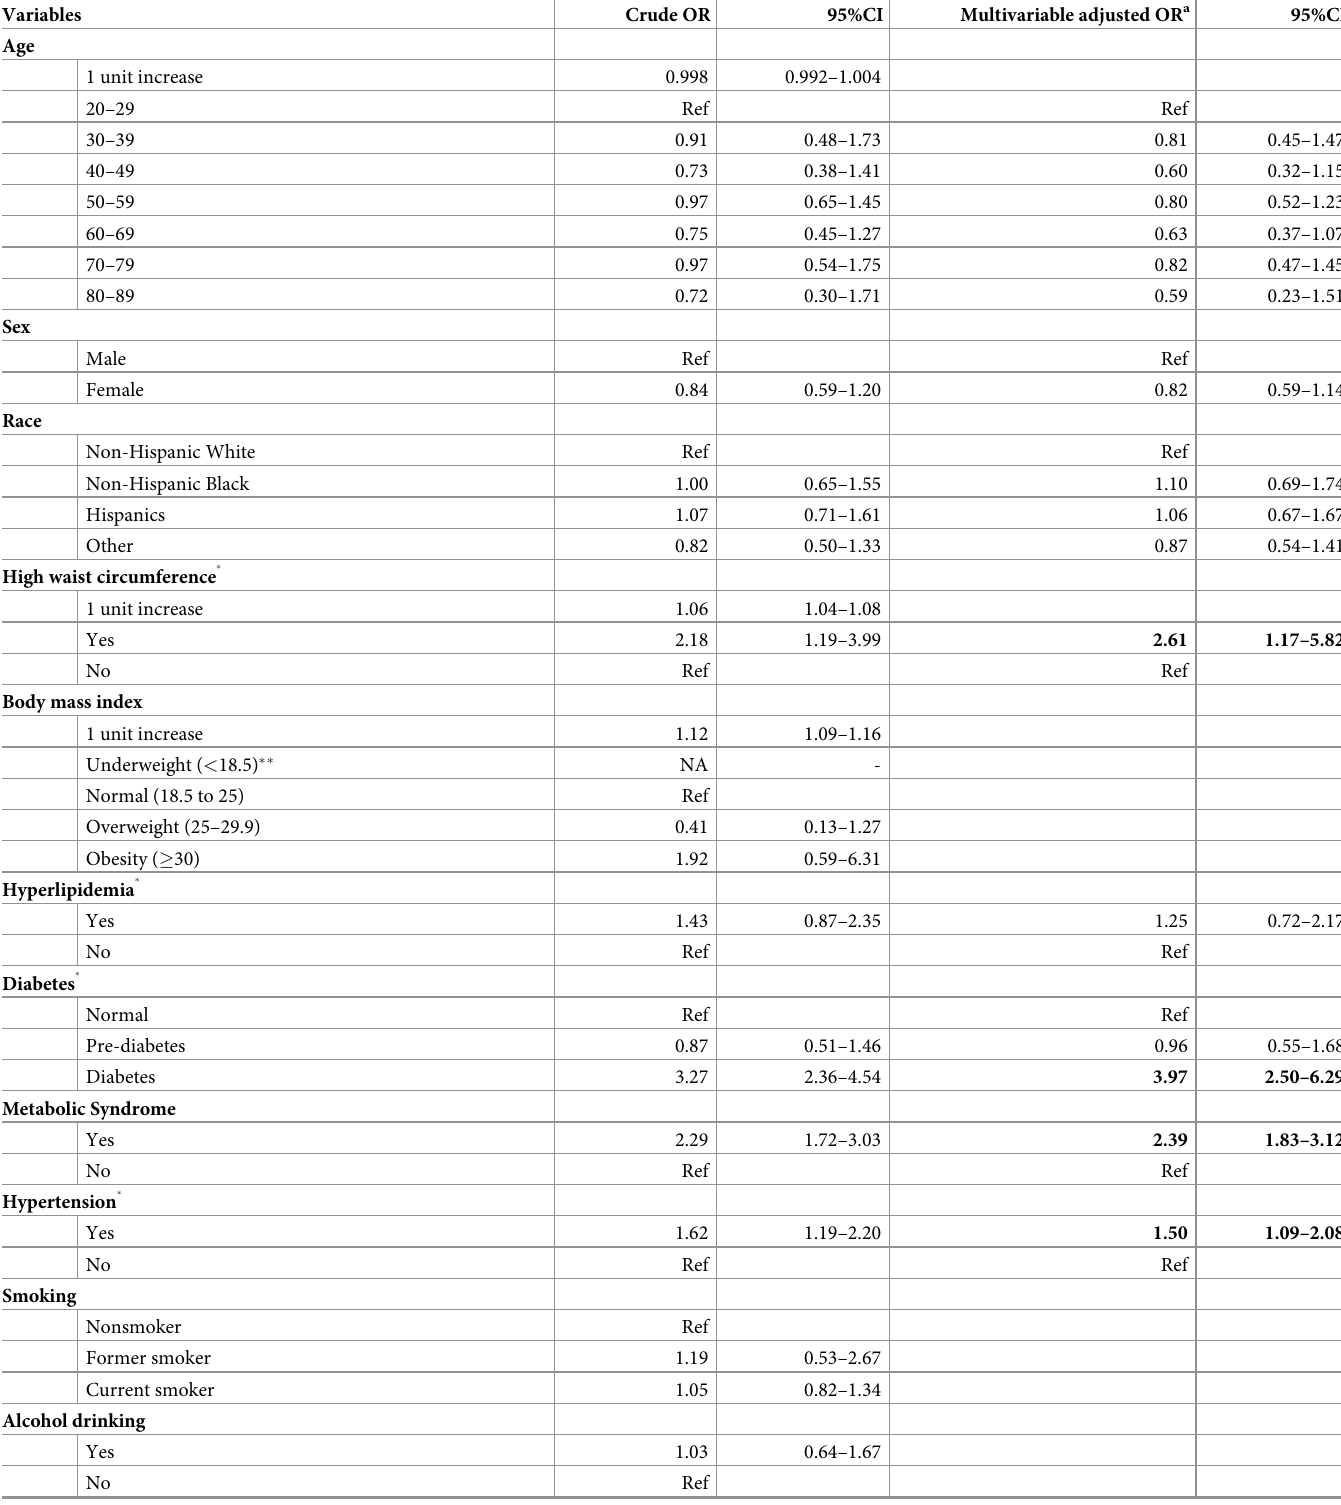
Table 6. Multivariable analysis for factors associated with significant NAFLD fibrosis among NAFLD participants by